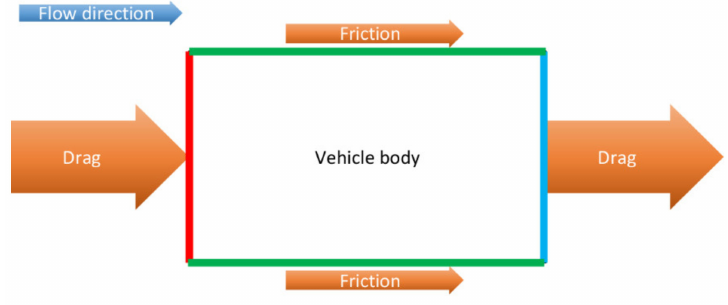
Figure 1. Forces on a vehicle body in a